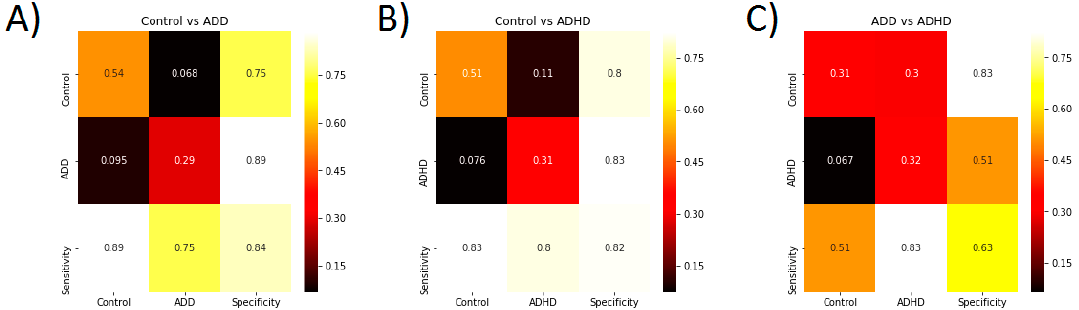
Figure 2. ( A ) Confusion matrix showing the model performance to classify controls vs. ADD patients. ( B ) Confusion matrix showing the model performance to classify controls vs. ADHD patients. ( C ) Confusion matrix showing the model performance to classify ADD vs. ADHD patients. For each plot, the sensitivity and specificity are also provided.